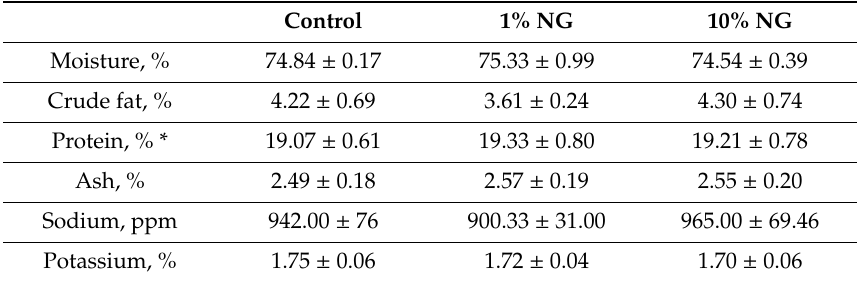
Table 7. Salmon meat proximate, sodium and potassium composition after 49 days of feeding the experimental diets.